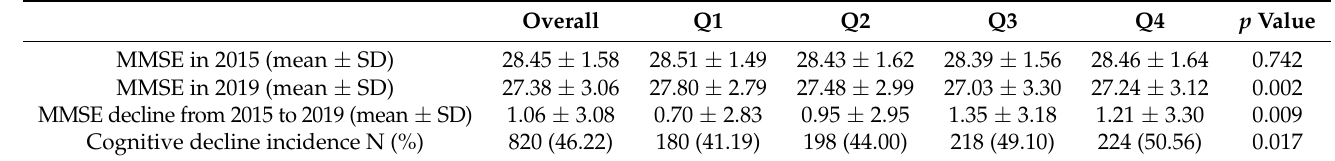
Table 2. Cognitive function in 2015 and 2019 in participants according to the TyG